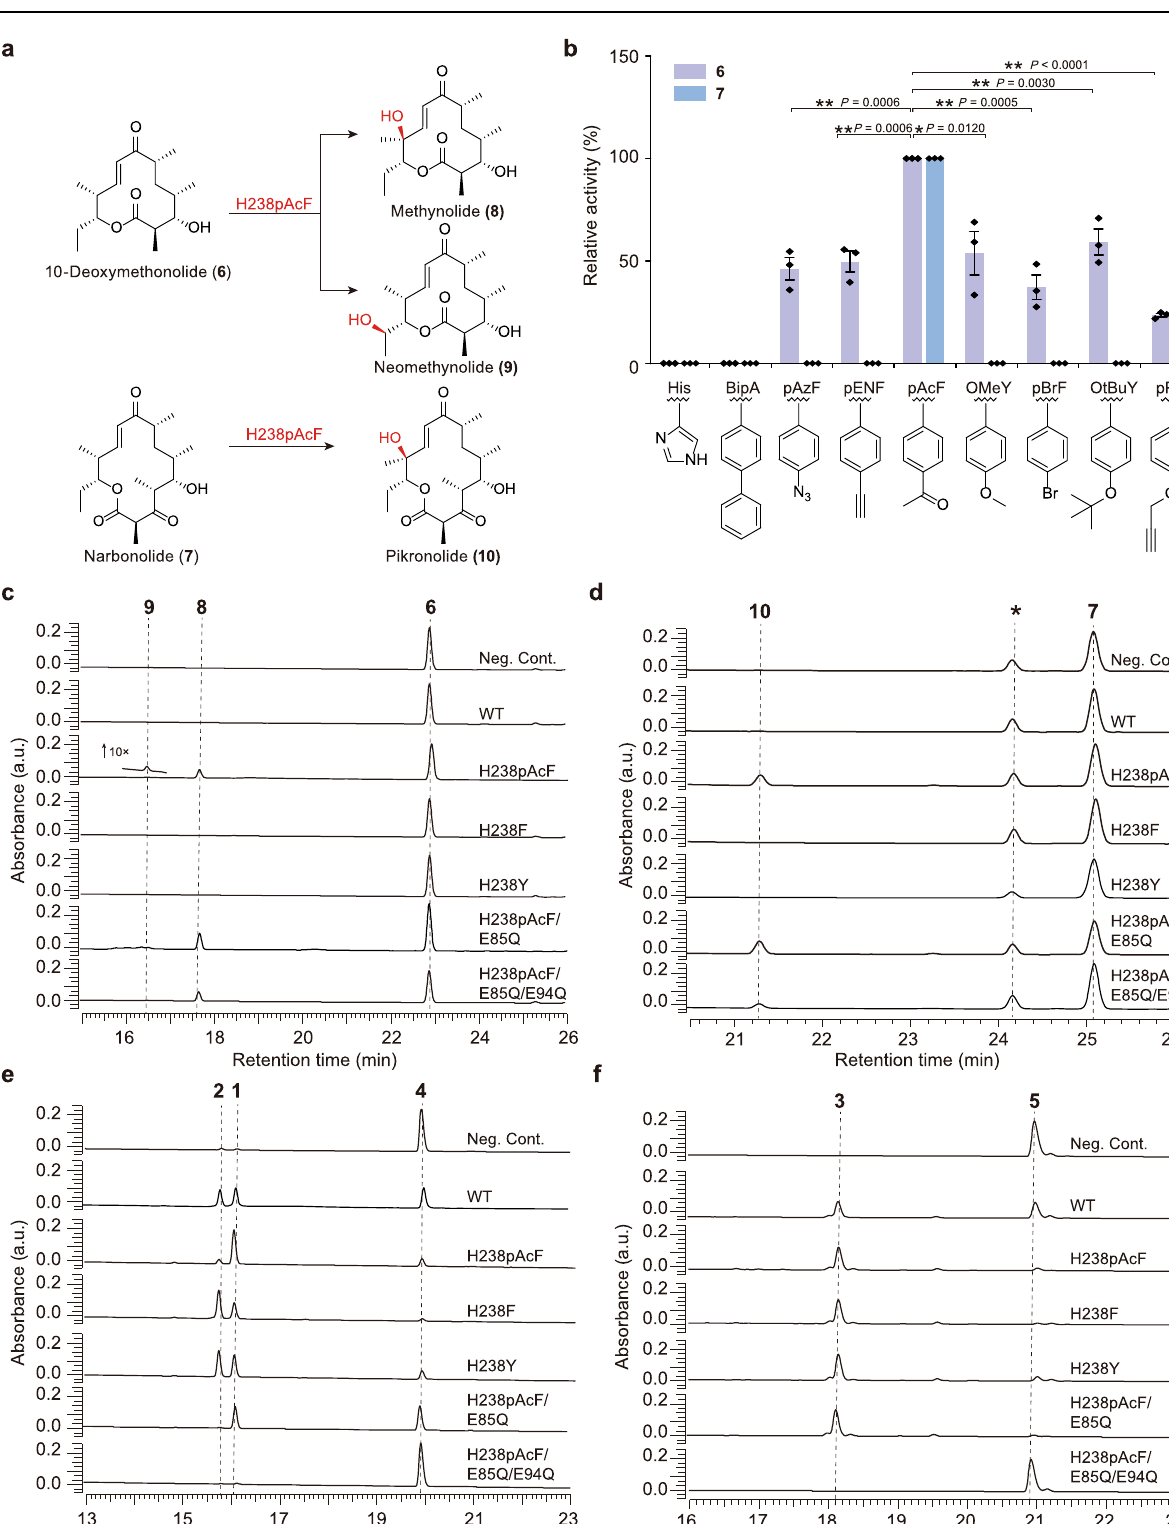
Nature Communications| (2023) 14:1669